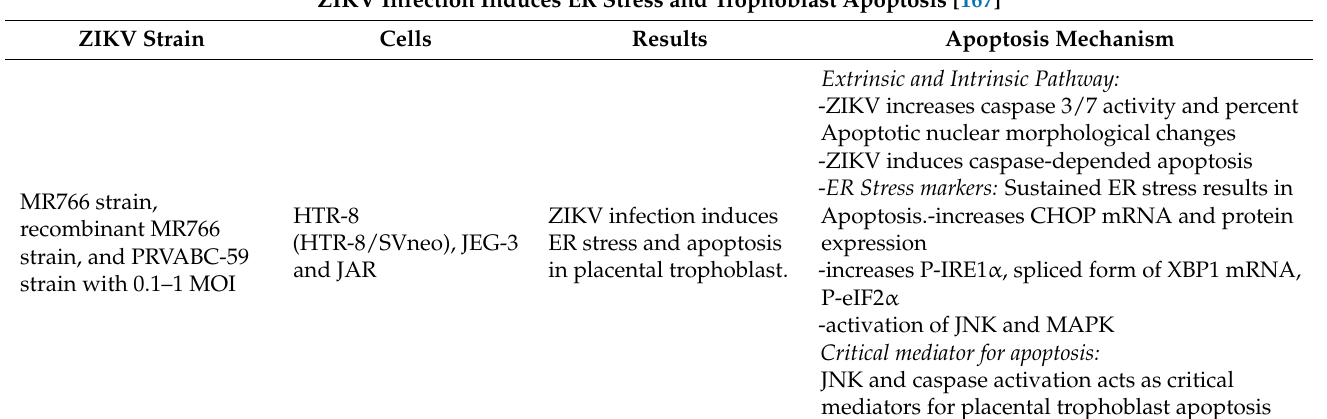
Table 3. ZIKV infection in placental trophoblast apoptosis involves activation of JNK and endoplasmic reticulum and Palmitoleate protects against ZIKV-induced ER stress and apoptosis in trophoblasts. ZIKV Infection Induces ER Stress and Trophoblast Apoptosis [167] Cells Results Extrinsic and Intrinsic Pathway: -ZIKV increases caspase 3/7 activity and